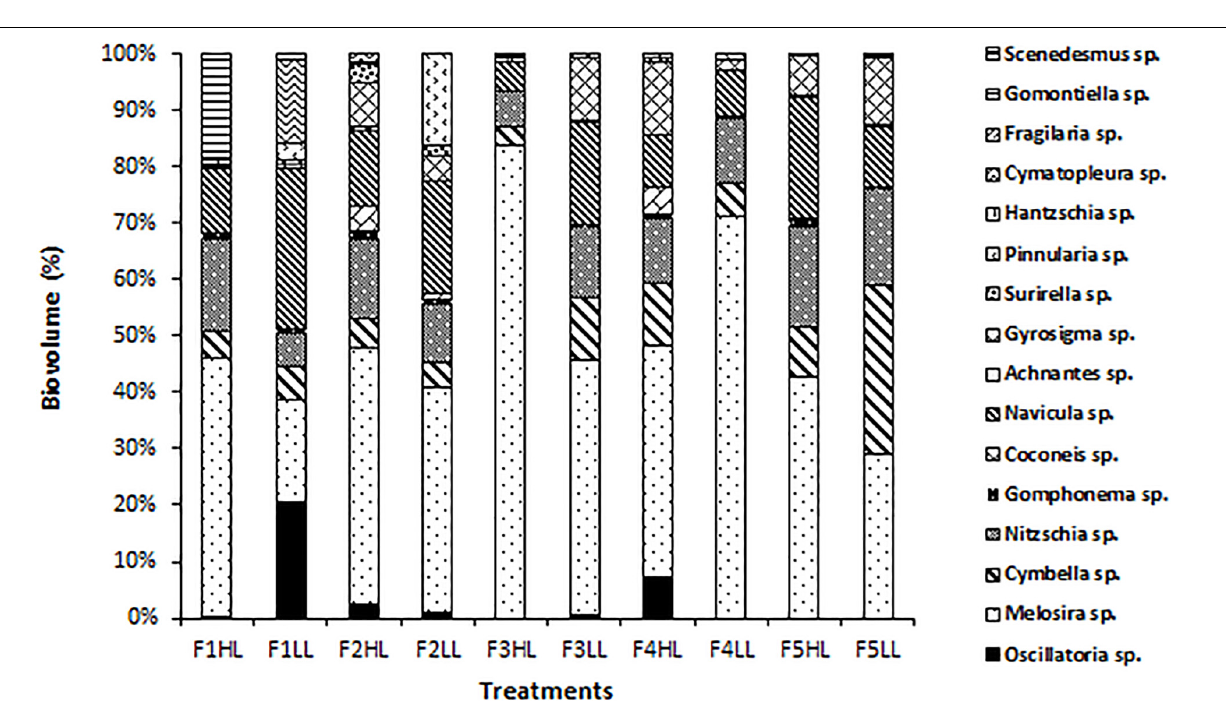
Frontiers in Microbiology |